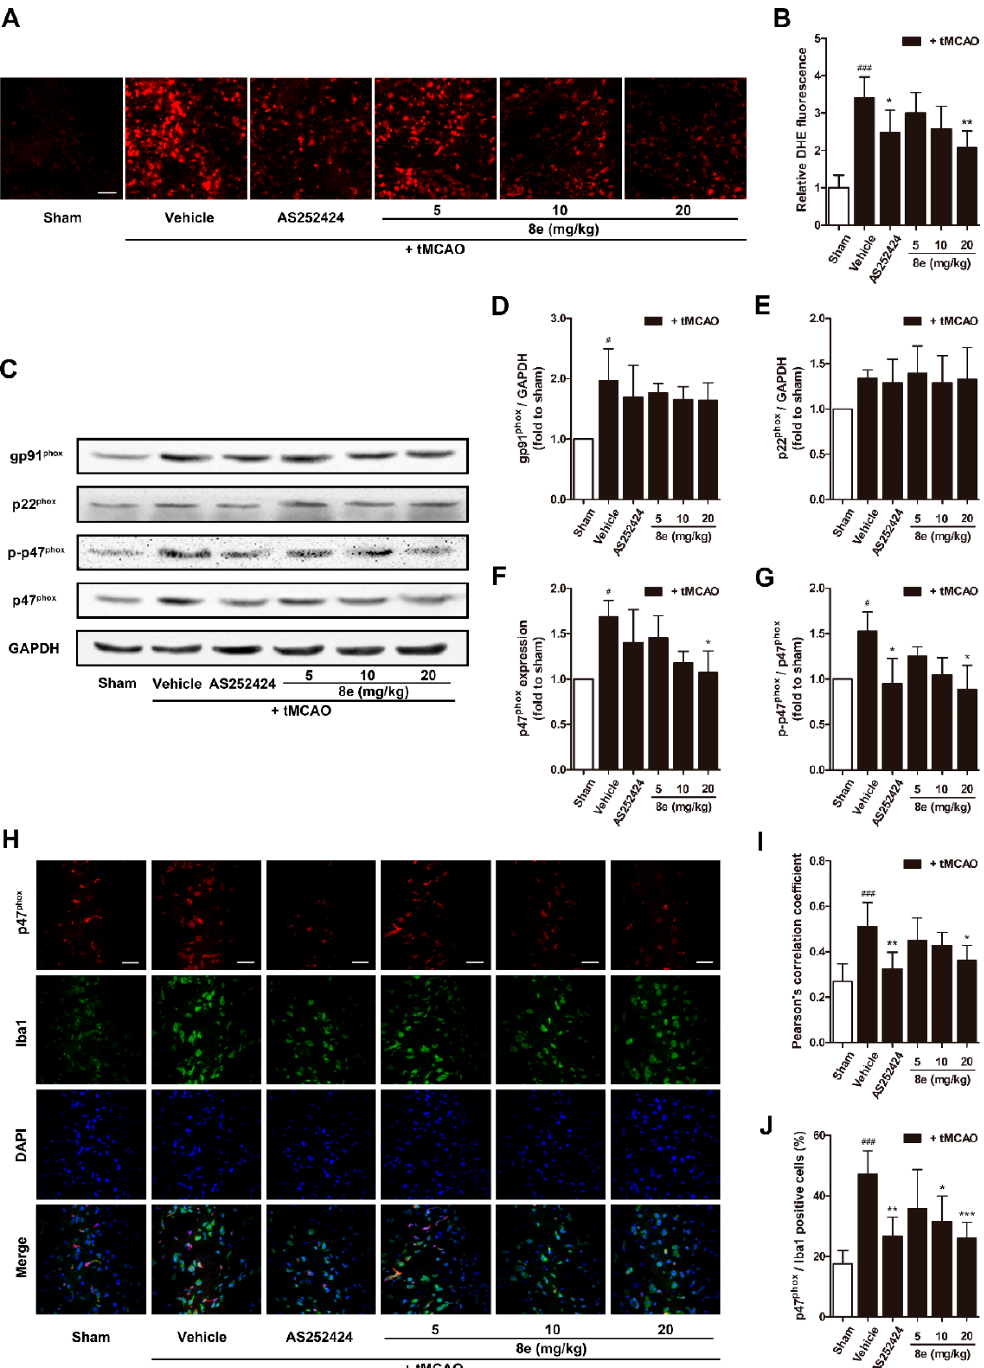
Figure 4. 8e attenuated superoxide production and the expression of p47 phox in microglia at 72 h after tMCAO in rats. ( A ) Representative images of DHE fluorescence in penumbral region. Scale bar = 50 μ m; ( B ) semiquantitative analysis of superoxide production in DHE fluorescence; ( C ) representative bands of Western blot assay for gp91 phox , p22 phox , p47 phox and p-p47 phox (Ser328) in penumbral region; ( D – G ) semiquantitative analysis of gp91 phox , p22 phox , p47 phox and p-p47 phox protein levels; ( H ) representative confocal fluorescence images of penumbral region labeled with p47 phox (red), Iba1 (green) antibodies and DAPI (blue). Scale bar = 50 μ m; ( I ) Pearson’s correlation coefficients between p47 phox (red) and Iba1 (green) fluorescence; ( J ) quantitative analysis of the percentage ratios of p47 phox /Iba1 positive cells to Iba1 positive cells. Data are presented as mean ± SD ( n = 3). # p < 0.05, ### p < 0.001 vs. sham group. * p < 0.05, ** p < 0.01, *** p < 0.001 vs. tMCAO + vehicle group.